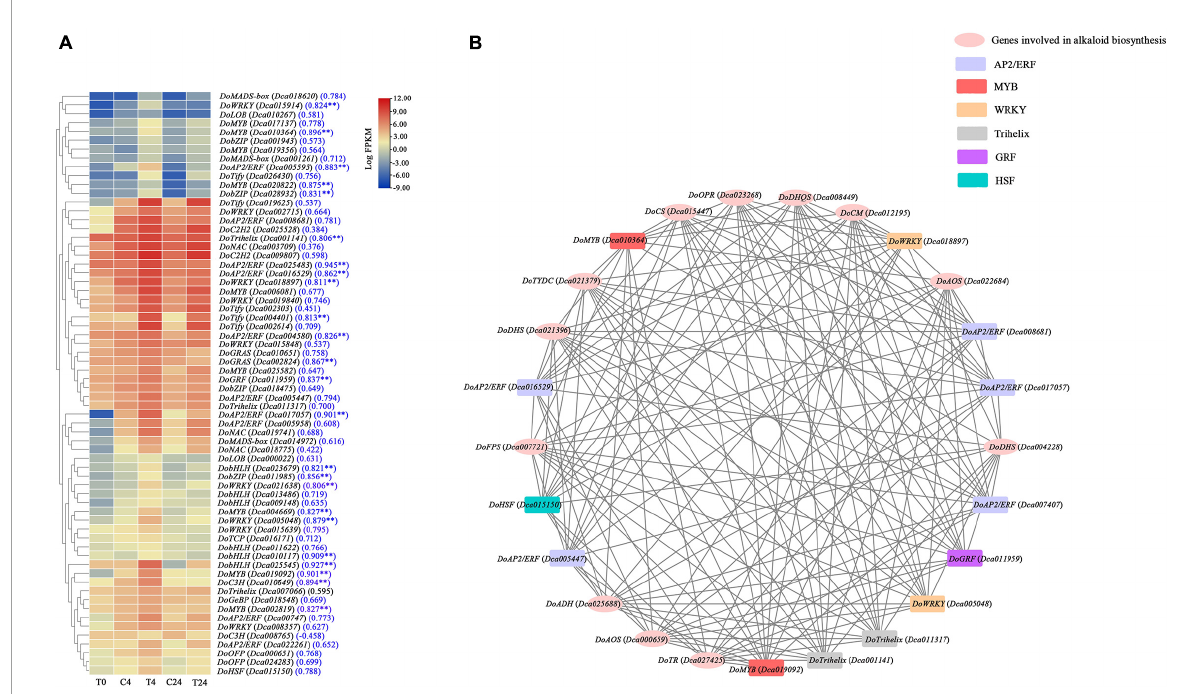
FIGURE9 Coexpression network of TFs and structure genes related to alkaloid biosynthesis pathway in D. officinale PLBs under the precursor and MeJA treatment. (A) Heat map displaying the expression of 66 TFs in different samples. (B) Construction of regulatory networks of TFs and structure genes related to alkaloid biosynthesis. ** p < 0.01 and | r | >